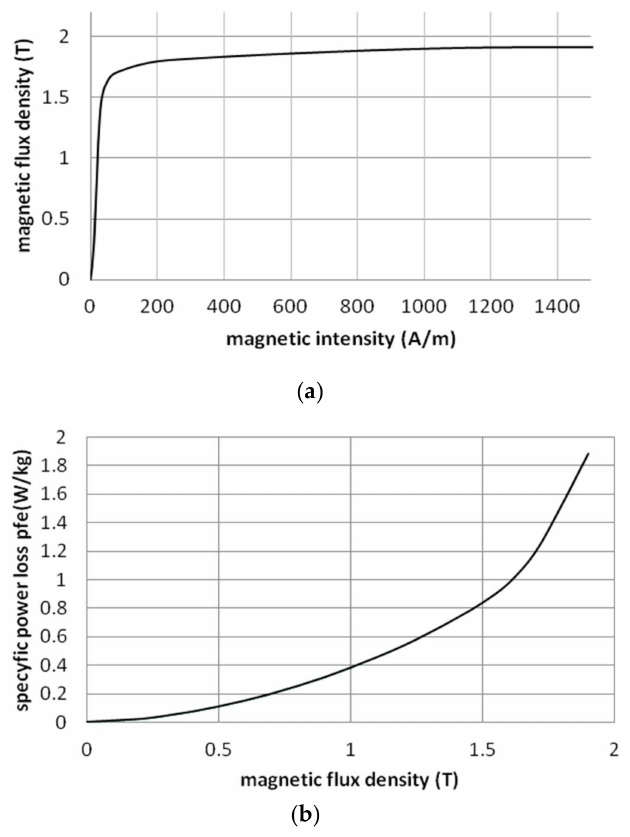
Figure 2. An ET 120-30 magnetization curve of the magnetic cores of the tested model of the cascade current transformer ( a ) and the specific power loss characteristics ( b